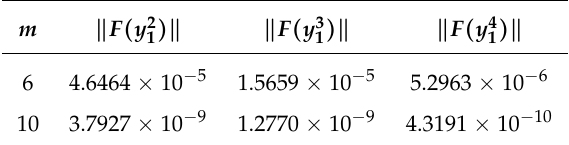
Table 3. Proximity of the first step of iterative methods (10) to the solution of integral Equation (15), for different values of m , the number of terms in the considered Taylor’s development